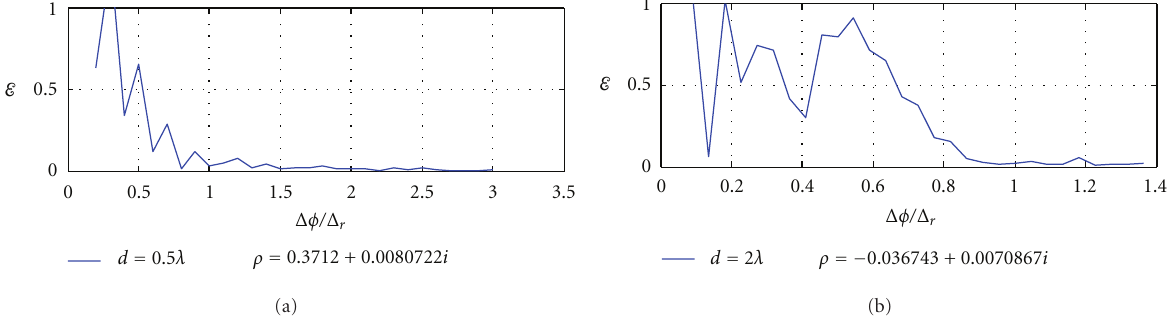
Figure 7: The error E as a function of Δ φ/ Δ r where Δ φ = π/ ( N + 1) . N is computed from (5) with γ = 2. Large values of Δ φ/ Δ r correspond to dense plane-wave distributions along in the ring in Figure 6.